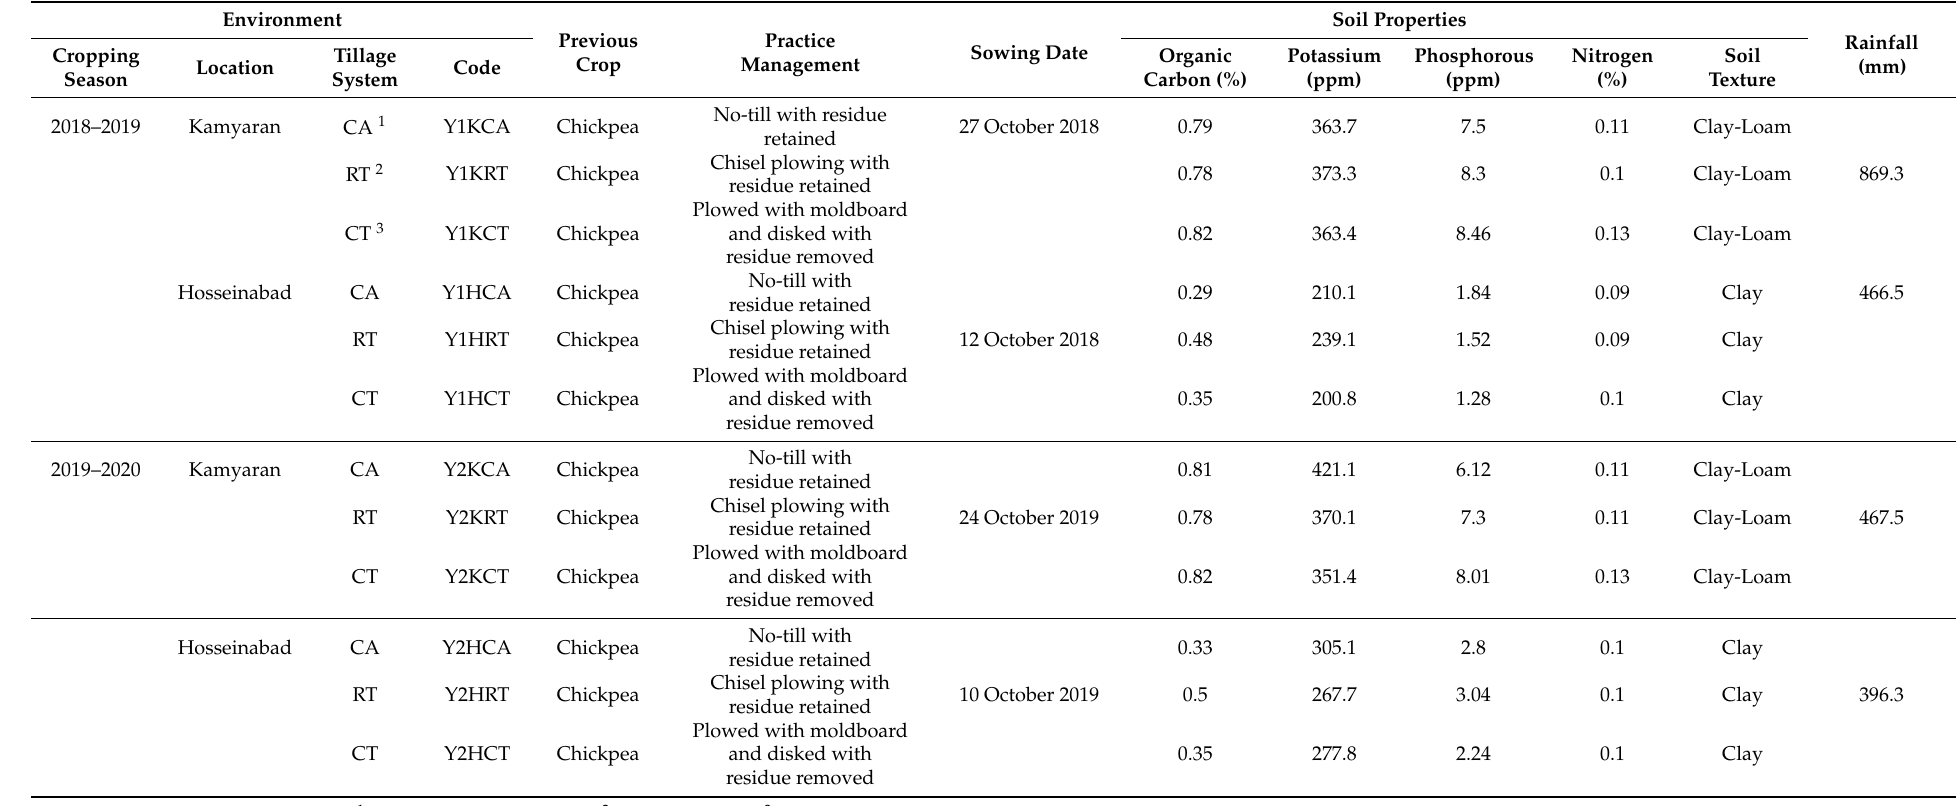
Table 2. Description of tillage systems, locations and